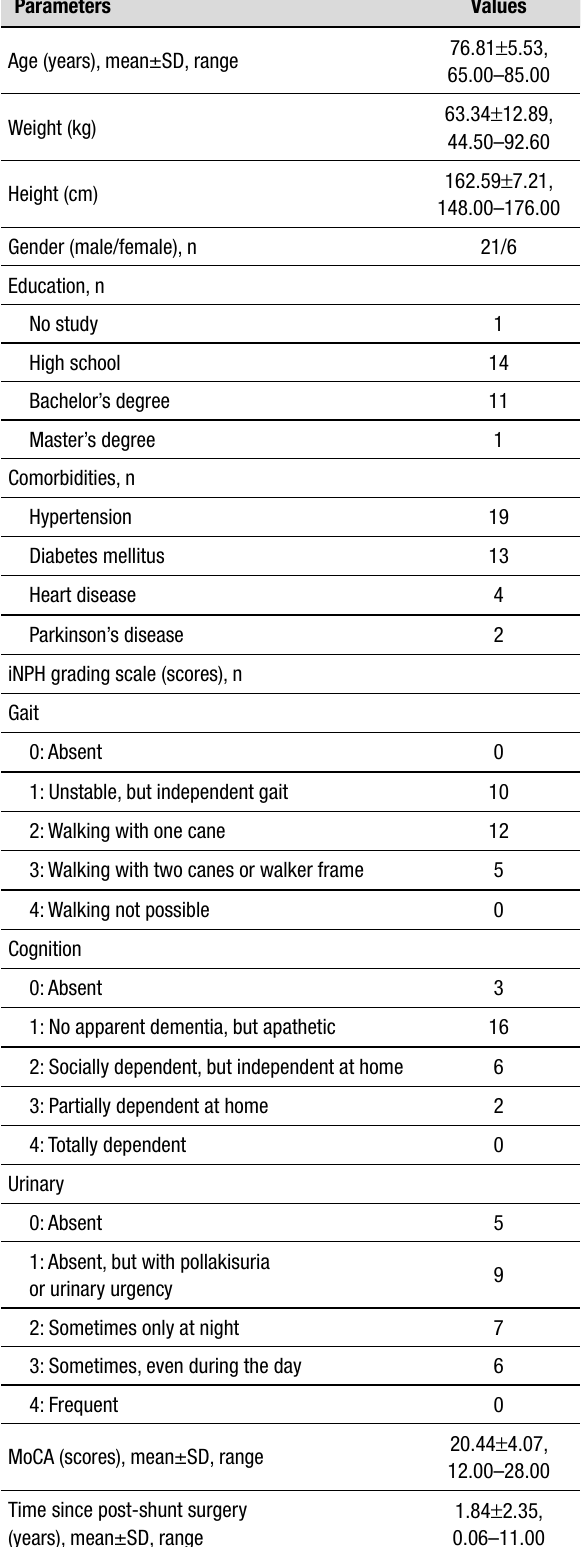
Table 1. Demographic data and clinical characteristics of the participants